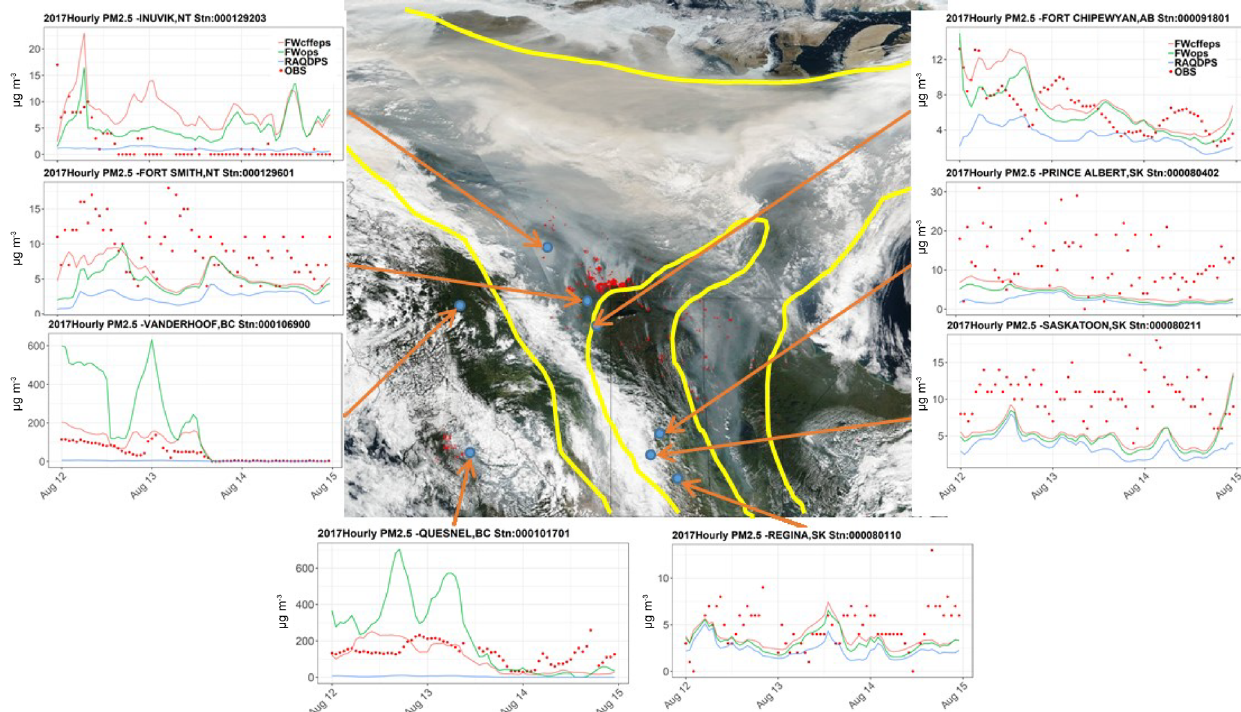
Figure 11. Time series of hourly surface PM 2 . 5 concentrations (µgm − 3 ) from 12–15 August 2017 for three model simulations and mea- surements (OBS) for selected stations, with station locations identified by orange arrows, and the VIIRS true colour satellite image (centre) for 13 August 2017 with yellow lines superimposed to aid comparison. Fire hotspots are represented as red dots in the VIIRS image. VIIRS image source: NASA (https://www.nasa.gov/image-feature/goddard/2017/smoke-and-clouds-obscure-skies-in-northern-canada, last